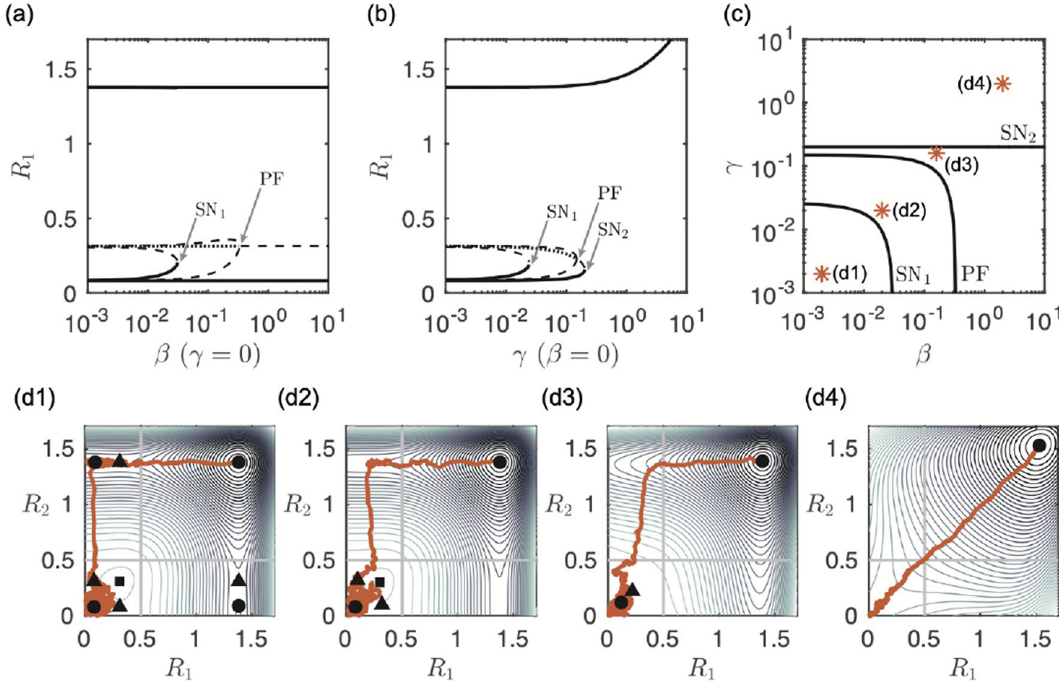
Figure 1. Bifurcation diagrams and example simulations of the bidirectionally-coupled two-node system. Shown are the bifurcation diagrams of amplitude R 1 of the transition states (equilibria) as a function of γ for β = 0 (additive coupling) in panel ( a ), and of β for γ = 0 (diffusive coupling) in panel ( b ). Stable states are shown as solid lines, saddle states as dashed lines and unstable as dotted lines. Saddle node bifurcations are labelled SN 1 and SN 2 , the pitchfork bifurcation is labelled P F . Panel ( c ) shows the position of the saddle node and pitchfork bifurcations in the ( β , γ )-plane. The orange stars indicate the values for which example simulations are shown in panel ( d ). Each subpanel ( d ) shows an example simulation in orange starting at z k ( 0 ) = 0 with the steady states in black (the circles are stable, the triangles are saddle and the squares are unstable (source)). Contour lines of the potential landscape are also plotted in shades of grey. The escape threshold for each node is shown as a solid line at